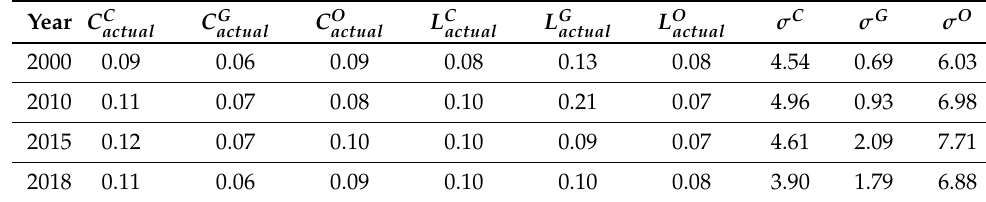
Figure A1. The evolution of networks characteristics (number of nodes and number of links) for coal ( C ), oil ( O ), natural gas ( G ), and fossil fuels ( FF ). Table A3. The evolution of small-worldness of the